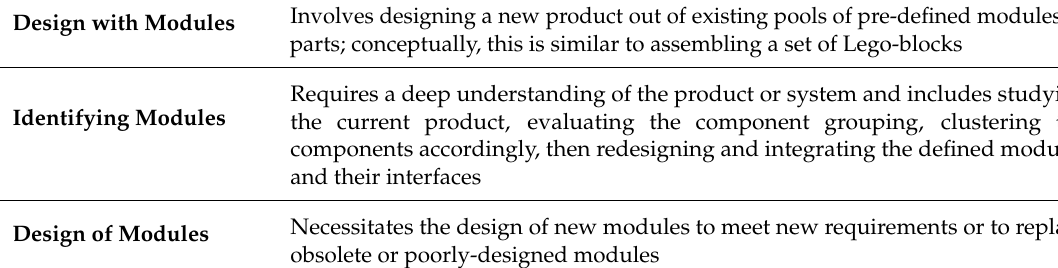
Table 1. Basic modular design